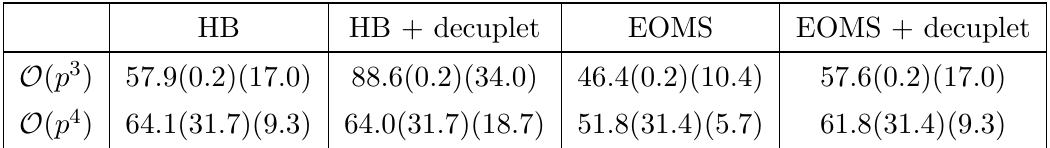
Table 7 . Results for (cid:27) 0 in MeV at third and fourth order. Here, \+decuplet" means the inclusion of the decuplet, HB denotes the heavy baryon and EOMS the covariant approach. The (cid:12)rst error comes from the uncertainties within the given order, the second error is an estimate of the neglected higher order e(cid:11)ects based on eq.